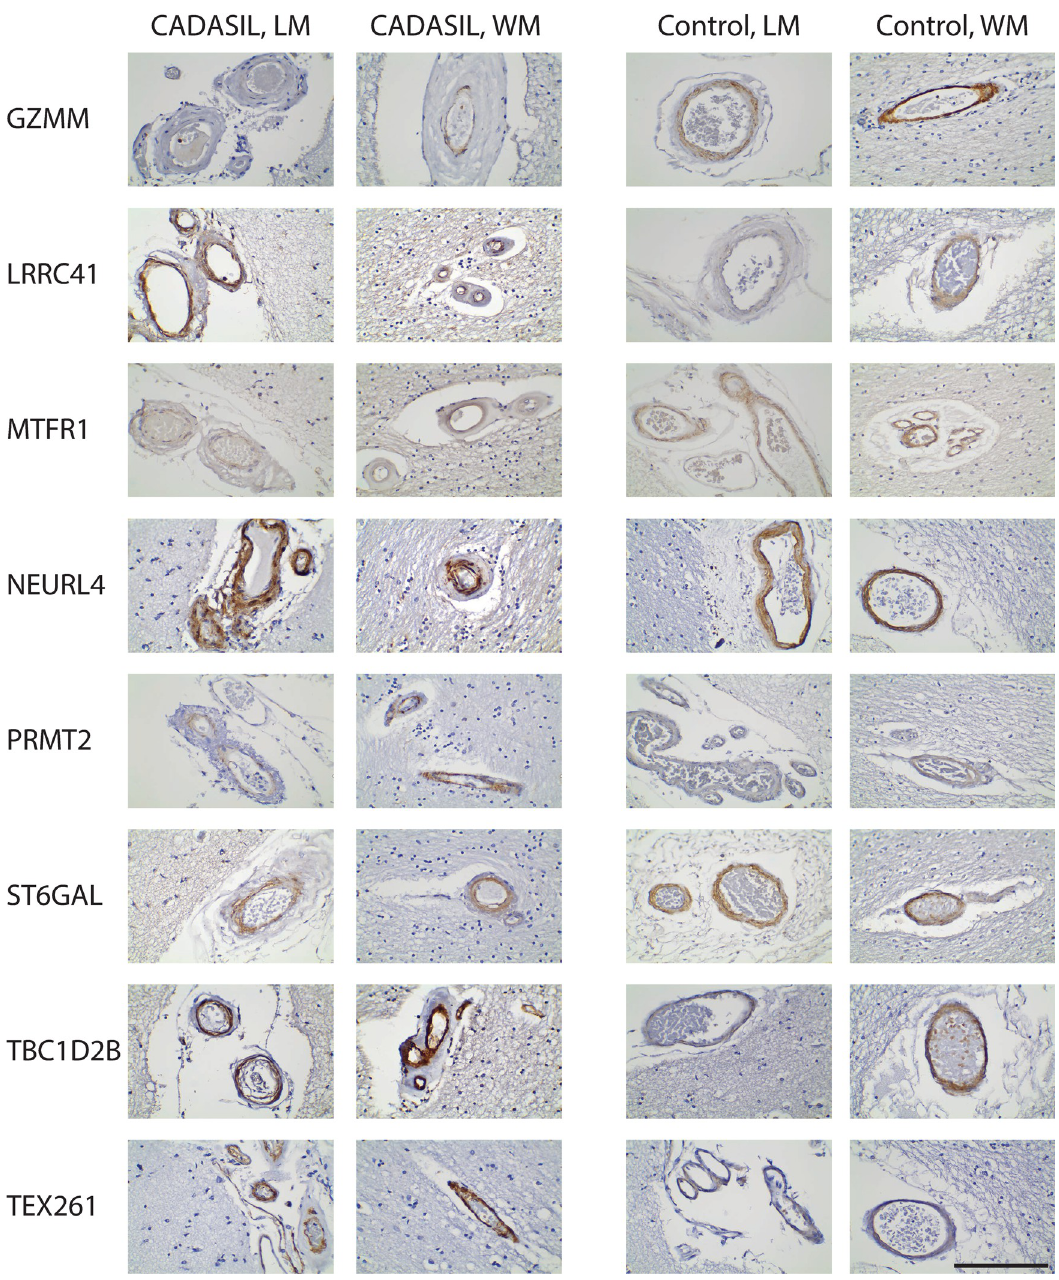
Fig 3. Vascular smooth muscle cell proteins in CADASIL and control arteries. Eight antibodies (labeled on the left) were used for immunohistochemical localization of respective smooth muscle antigens in CADASIL and control brains. Both leptomeningeal (LM) and white matter (WM) vessels are shown to illustrate representative positively-stained vessels. Scale bar shows 100